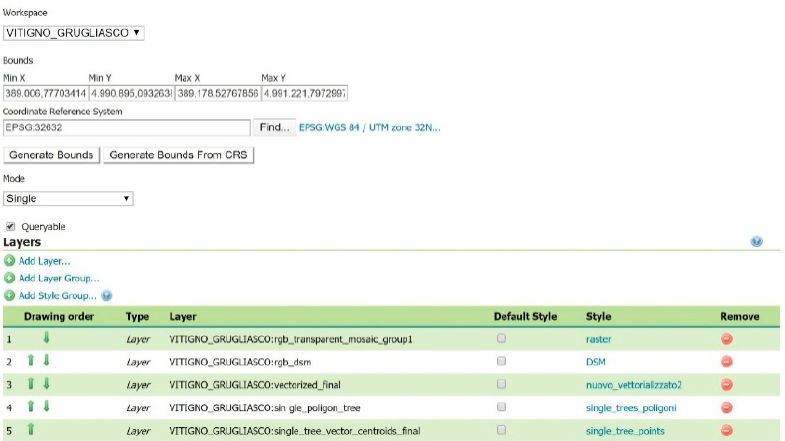
Figure 14. OpenLayers visualisation. Figure 13. OpenLayers visualisation.